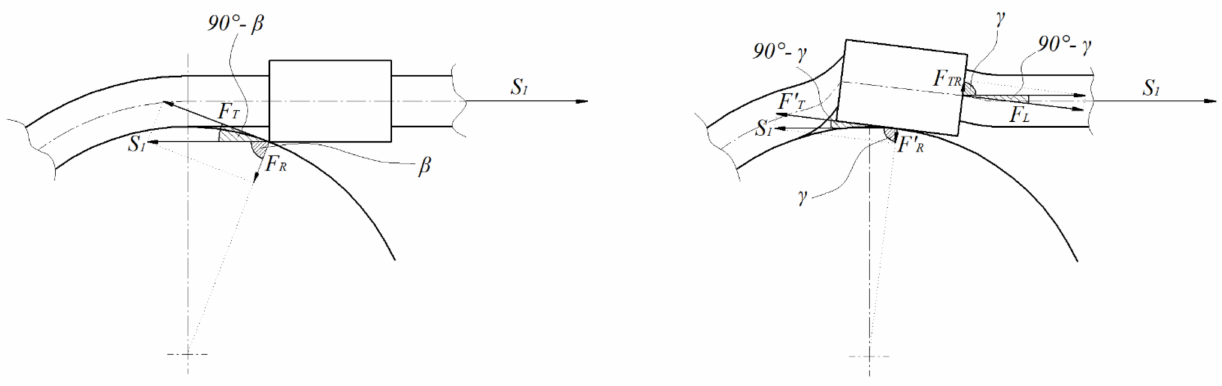
Figure 3. Stress distribution in the roller-belt-mechanical fastener configuration during: ( left ) ramp-up, ( right ) circulating around the roll. Explanations: F R —radial force during the run-up, F (cid:48) R —radial force while going around the roller, F T —tangential force during the run-up, F (cid:48) T —tangential force while going around the roller (which is the same as the friction force on the bottom surface of the joint), F TR —transverse force, F L —longitudinal